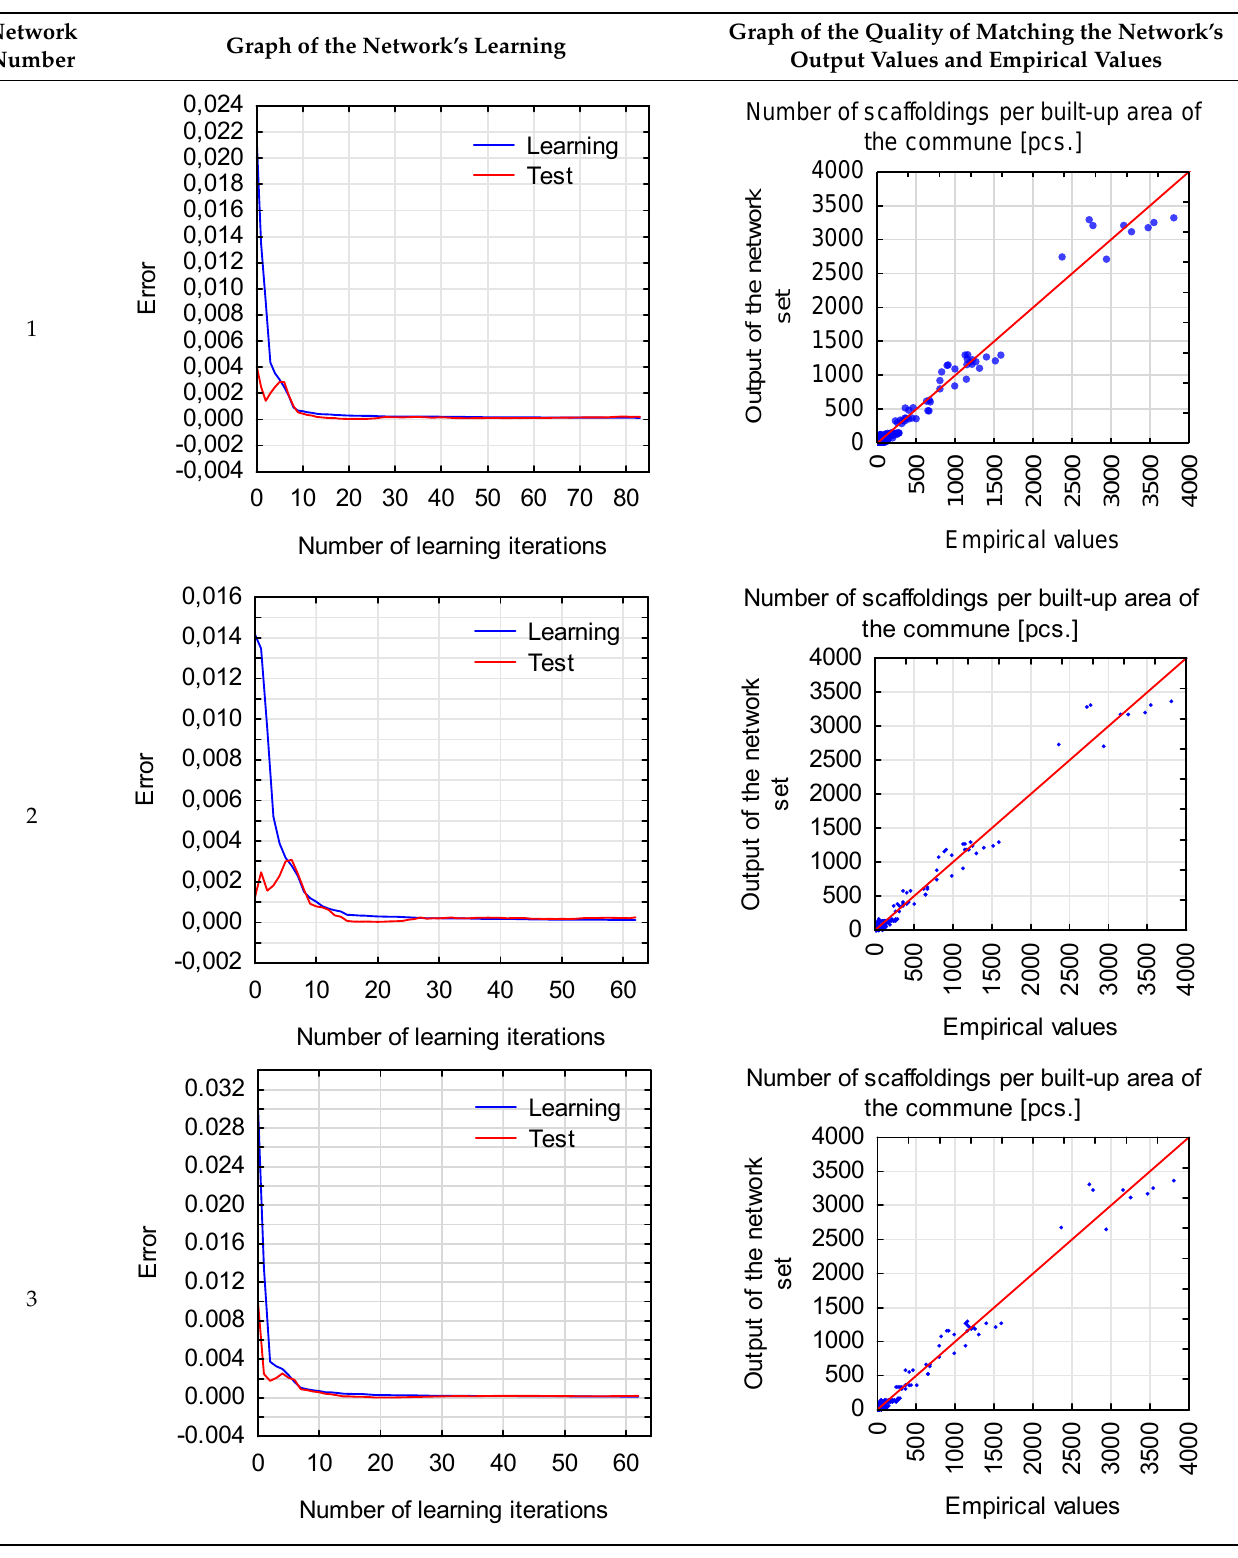
Table 4. Characteristics of the developed neural networks—graphs.